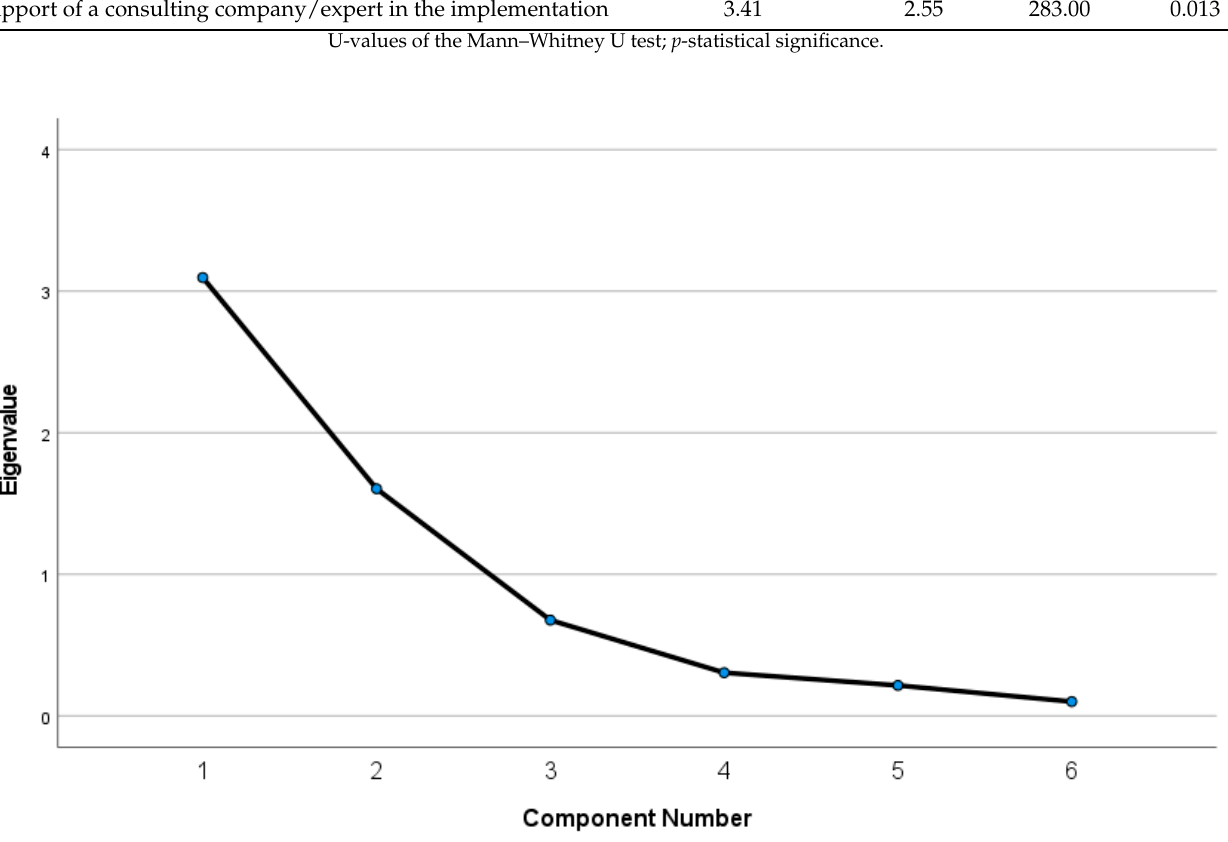
Figure 7. Scree plot in the principal component analysis regarding support for the decision-making process to implement Industry 4.0 solutions.